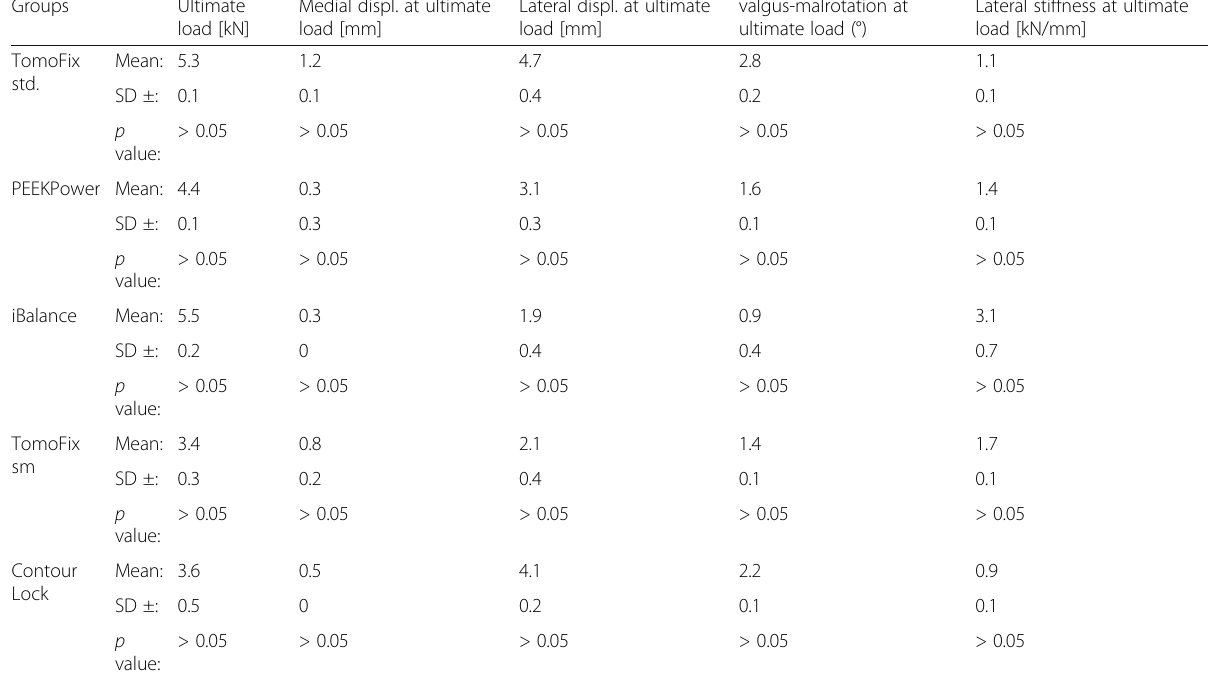
Table 5 Results of the t-test comparing the previous tested implants to the Activmotion implant. Mean values were compared. All p values were greater than